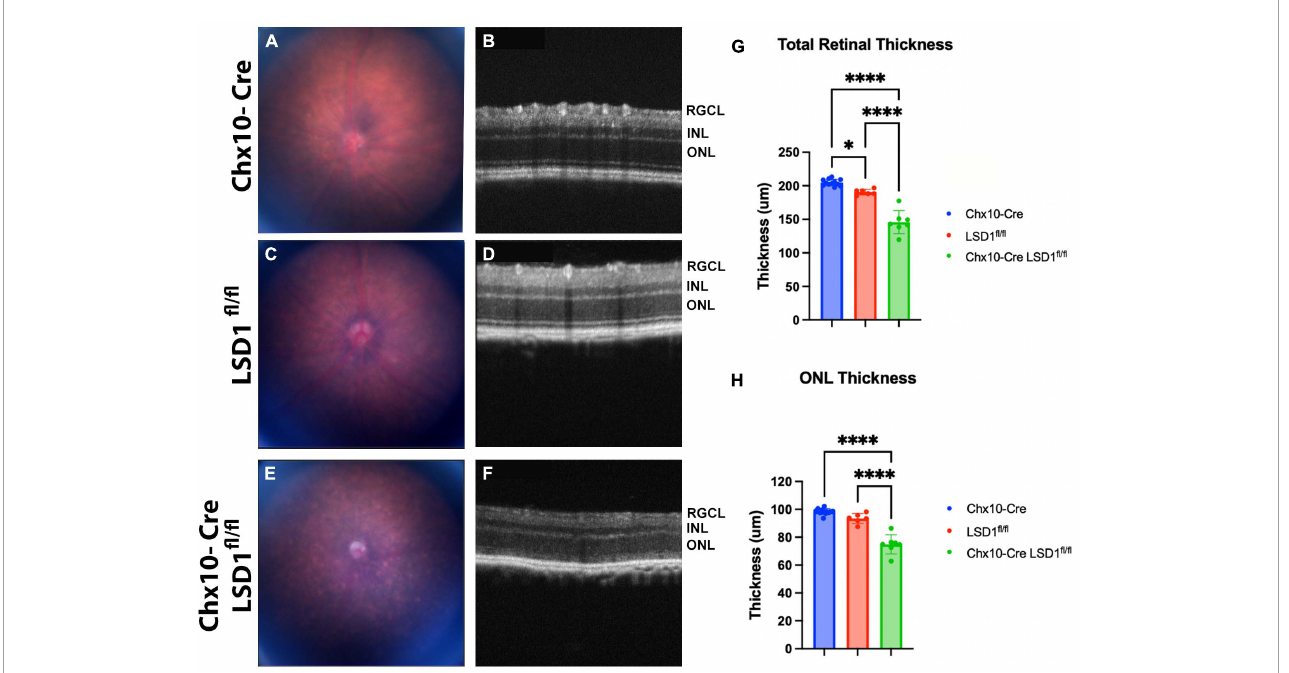
FIGURE3 Chx10-Cre Lsd1 fl / fl animals show an increased mottled and speckled appearance in fundus photos (E) compared to both control groups (A,C) . In SD-OCT images, the control groups (B,D) have normal retinal morphology with clear, distinct layers; however, the Chx10-Cre Lsd1 fl / fl mice have retinas that are hazy and less distinct (F) . After quantification of SD-OCT images by a masked individual, the Chx10-Cre Lsd1 fl / fl showed significantly thinner total retinas and ONLs compared to both control groups (G,H) . One–Way ANOVA with Tukey’s multiple comparisons test. * P -value < 0.05; **** p -value < 0.0001. Samples sizes: Chx10-Cre ( n = 12), Lsd1 fl / fl ( n = 6), Chx10-Cre Lsd1 fl / fl ( n = 7). Full list of statistical results can be found in Supplementary Tables 5, 6